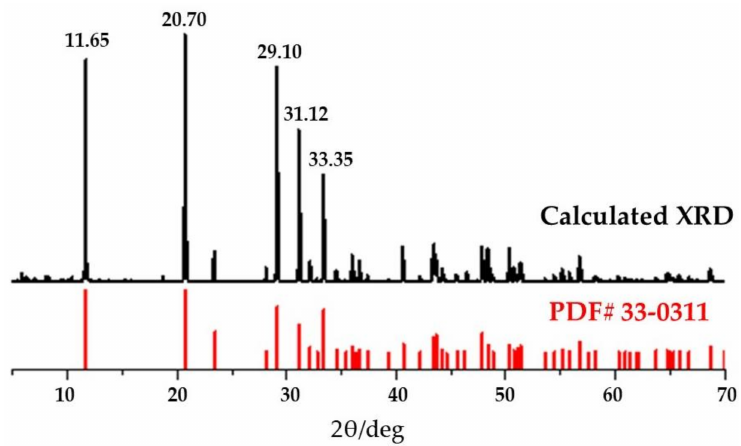
Figure 7. CaSO 4 · 2H 2 O modeling process ( a ) unit crystal; ( b ) 4 Å × 2 Å × 3 Å supercell; ( c ) modified crystal with wedge pores. (White balls are hydrogen, red balls are oxygen, yellow balls are sulfur, and green balls are calcium.)